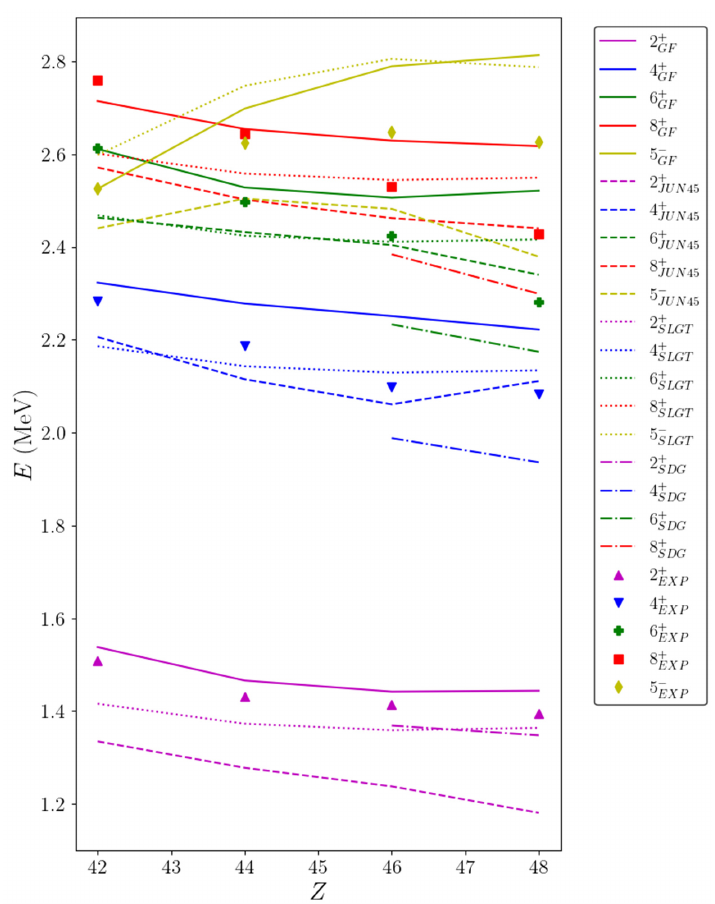
Figure 3. Systematics of the level energies in the N (number of neutrons) = 50 isotonic chain, for even- Z (atomic number) nuclei. Experimental data shown with colored symbols are taken from [101]. The energy of the 5 - state in 98 Cd is taken from [102]. The lines shown in corresponding colors represent theoretical level energies. Calculations were done with the NuShellX code [87] using em- pirical interaction GF [85], SLGT [86] in the π ( g 9/2 p 1/2 ) and realistic effective interaction JUN45 [78] in the π ( f 5/2 , p 3/2 , p 1/2 , g 9/2 ) and SDG in πυ ( g 9/2 , d 5/2 , g 7/2 , s 1/2 , d 3/2 ) model spaces [92]. The values of single-parti- cle level energies were adopted from [1]. A pure π g 9/2n configuration explains the levels 2 + –8 + . The 5 - states are obtained from the π p 1/2 − 1 g 9/2n + 1 coupling. The "EXP" denotes experimental values. Most of the shell-model calculations, presented for N = 50 isotones, can reproduce level energies relatively well, with less accuracy for the 6 + and 8 + states. For the GF shell- model calculation (shown with continuous lines in Figure 3), the agreement is very good (note the expanded energy scale) in the lower shell e.g., for 92 Mo, which is trivial as it was used to fit the two-body matrix elements (TBME) and therefore effectively includes the contribution of lower shells. It is also understandable that there is a trend of increased level deviation of the g 9/2n coupling towards 100 Sn.